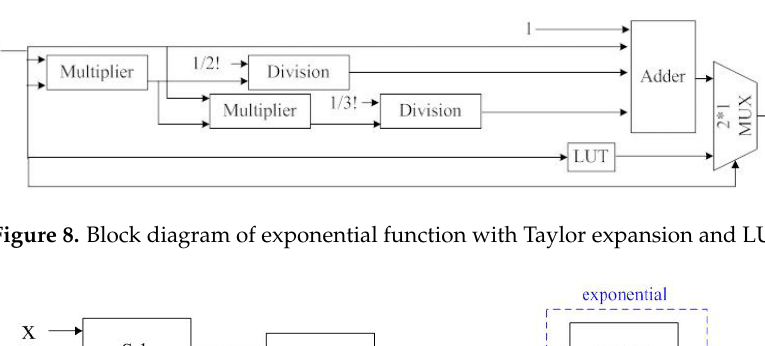
Figure 7. Taylor approximation of a Gaussian function. Electronics 2018 , 7 , x FOR PEER REVIEW